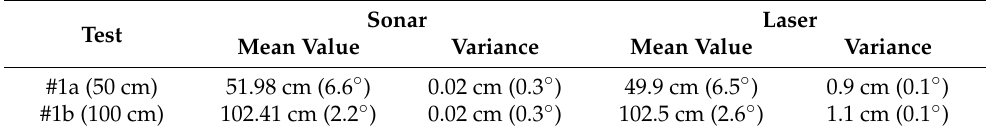
Table 1. Sonar and laser rangefinder distance measures.